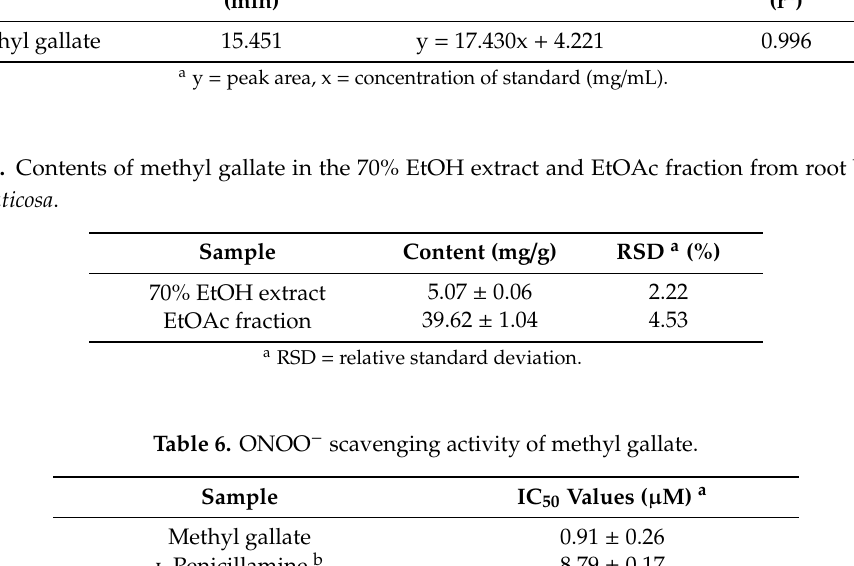
Figure 2. HPLC chromatograms of methyl gallate ( A ), 70% EtOH extract from P. su ff ruticosa ( B ), and EtOAc fraction ( C ) of the 70% EtOH extract. Table 4. Retention time, calibration equation, and correlation coe ffi cient of methyl gallate. Compound